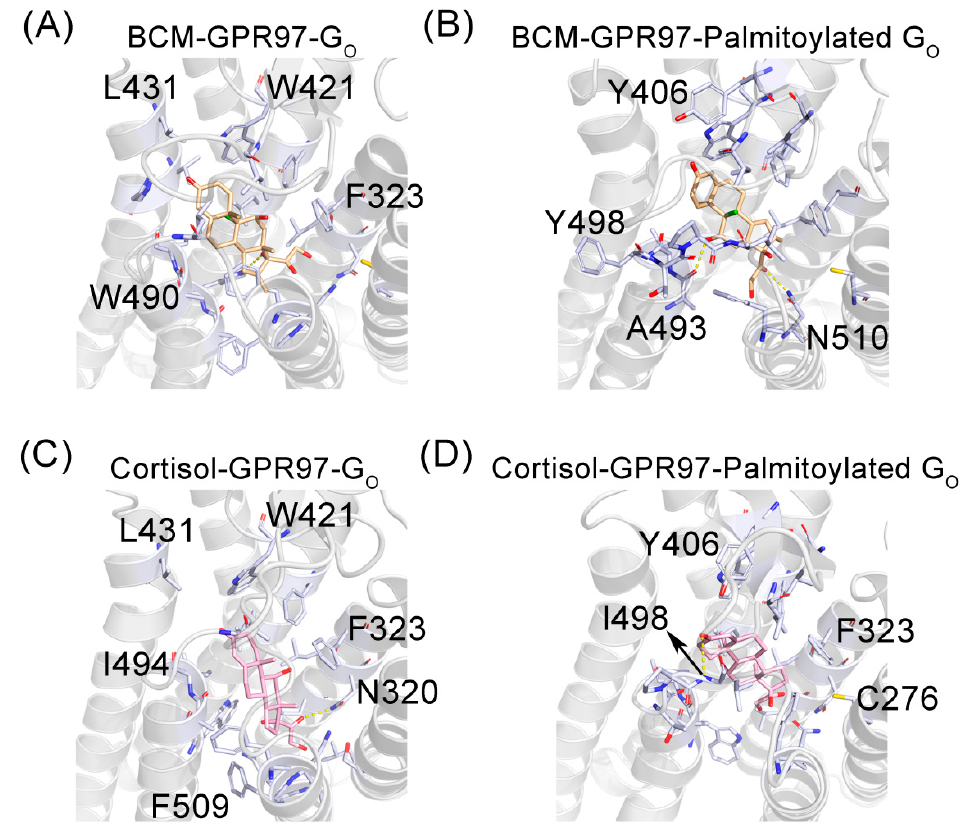
Figure 6. The detailed interactions of BCM (slate blue) and cortisol (pink) with GPR97 within BCM– GPR97–G o ( A ), BCM–GPR97–palmitoylated G o ( B ), cortisol–GPR97–G o ( C ), and cortisol–GPR97– palmitoylated G o ( D ) systems. The residues involved in the interactions with GPR97 are indicated by light-blue stick models. The hydrogen bonds are depicted as yellow lines.